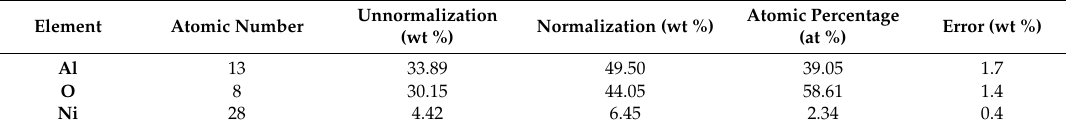
Atomic Percentage (at